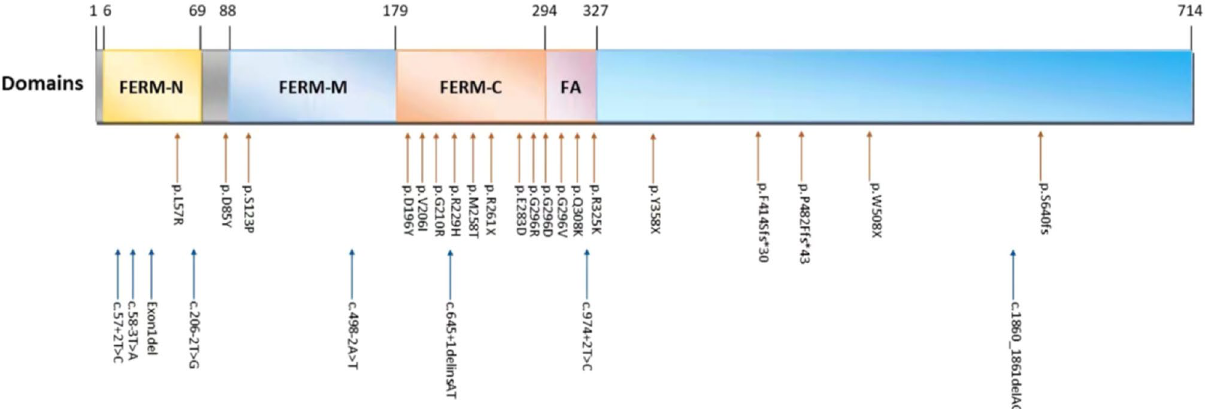
Figure 1. Schematic representation of 28 novel FRMD7 mutations.